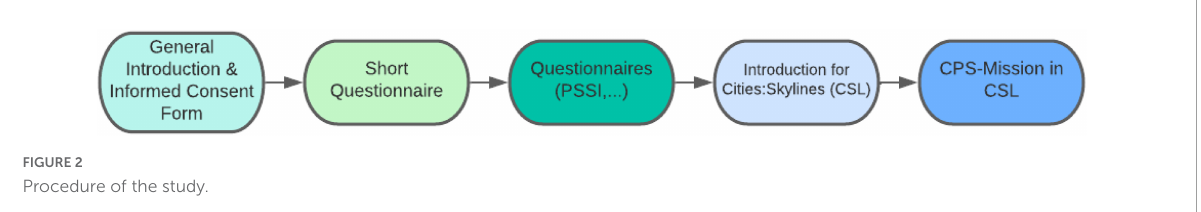
FIGURE2 Procedure of the study.